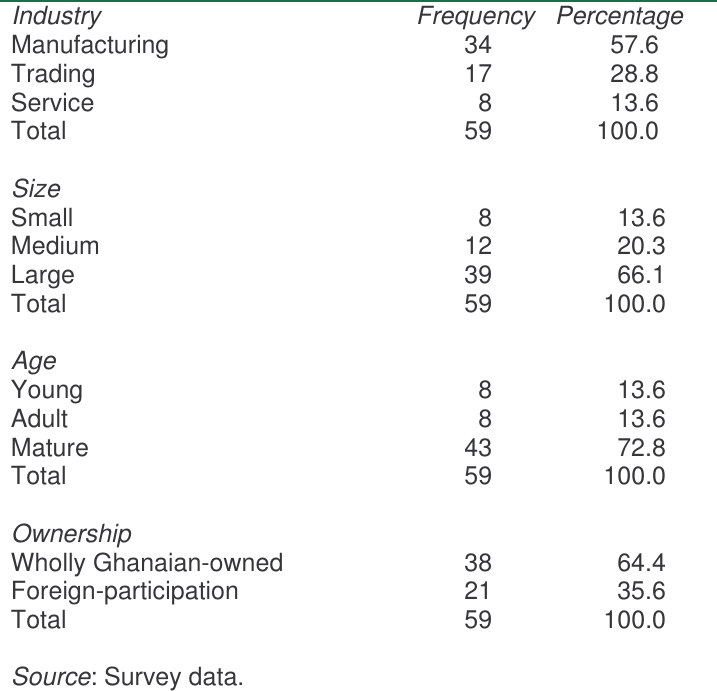
Table 1: Characteristics of Sampled